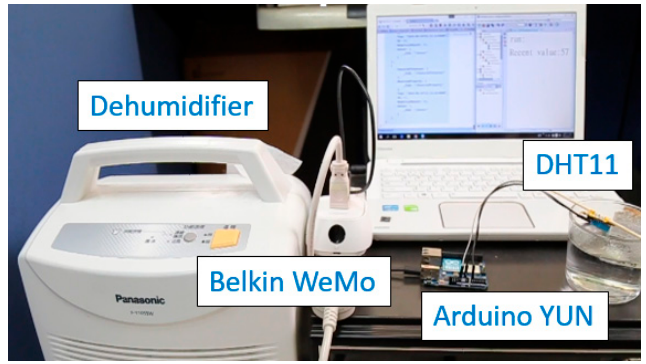
Figure 16. The prototype of an automatic dehumidifier.